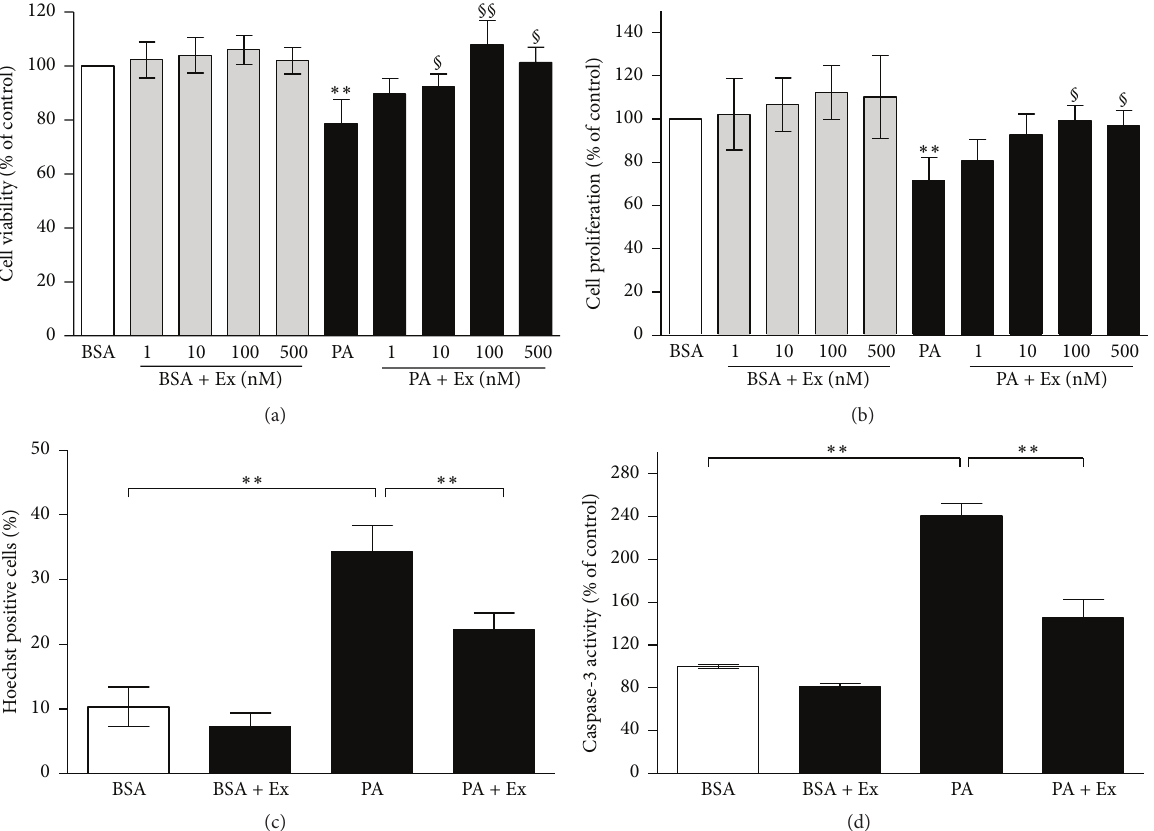
Figure 1: Exendin-4 inhibits apoptosis in palmitate-treated MIN6 cells. MIN6 cells were incubated in 0.5% BSA (BSA) or 0.4 mM palmitate added 0.5% BSA (PA), in the presence or absence of increasing concentrations of exendin-4 (1–500 nM) (Ex), in serum-free DMEM for 24 h. Exendin-4 was added at a concentration of 100 nM for Hoechst33258 staining and caspase-3 activity assays. (a) Cell survival was assessed by MTT assay. Cell survival results are expressed as percentage of control (cells treated with BSA alone) and represent the mean ± SE of five independent experiments. ∗∗ 𝑝 < 0.01 , versus BSA; § 𝑝 < 0.05 , §§ 𝑝 < 0.01 , versus PA. (b) Cell proliferation was evaluated by BrdU incorporation kit. Cell proliferation results are expressed as percentage of control (cells treated with BSA alone) and represent the mean ± SE of five independent experiments. ∗∗ 𝑝 < 0.01 versus BSA; § 𝑝 < 0.05 , §§ 𝑝 < 0.01 , versus PA. (c) Apoptosis was evaluated by Hoechst33258 staining. Values are expressed as percentage of apoptotic cells and represent the mean ± SE of three independent experiments. ∗∗ 𝑝 < 0.01 . (d) Apoptosis was assessed by caspase-3 activity assay. Values are expressed as percentage of control (cells treated with BSA alone) and represent the mean ± SE of three independent experiments. ∗∗ 𝑝 < 0.01